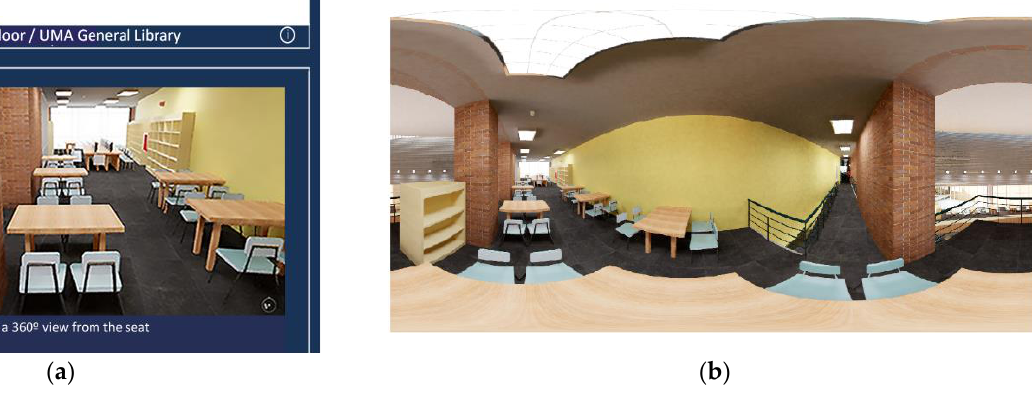
Figure 4. Link to the online 360-degree image viewer from the app’s query interface (Supplementary Materials S2) ( a ) and stereoscopic image created with Revit in A360 ( b ).